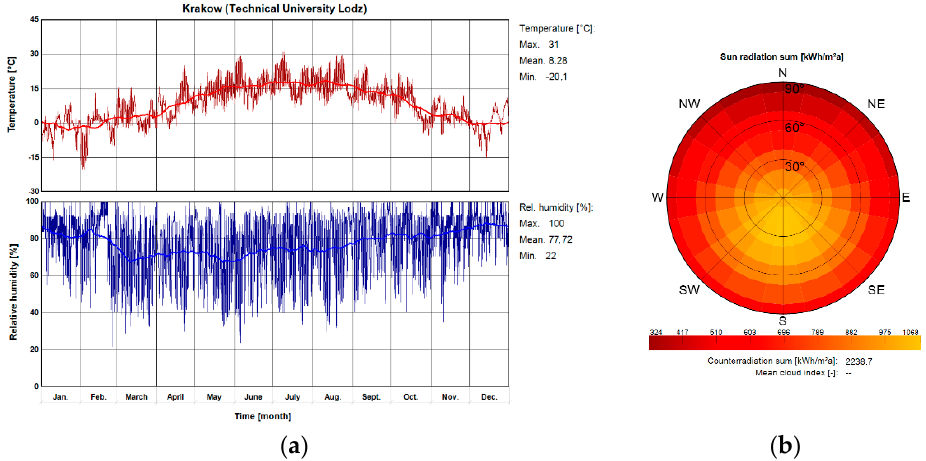
Figure 5. TRY characteristics for Krakow: ( a )—air temperature and relative humidity; ( b )—solar radiation intensity. Source: WUFIplus ® database.